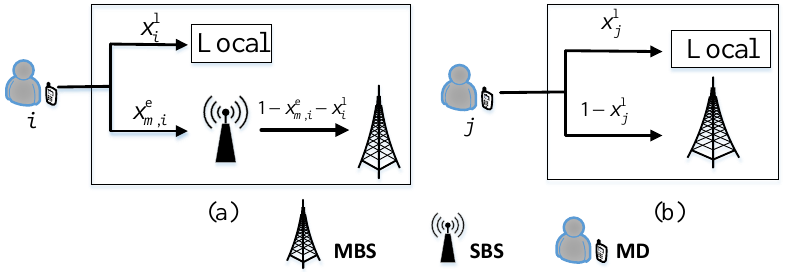
Figure 2. Computational offloading strategies for the UE in different scenarios: ( a ) only associated with an MBS, ( b ) associated with the SBS and